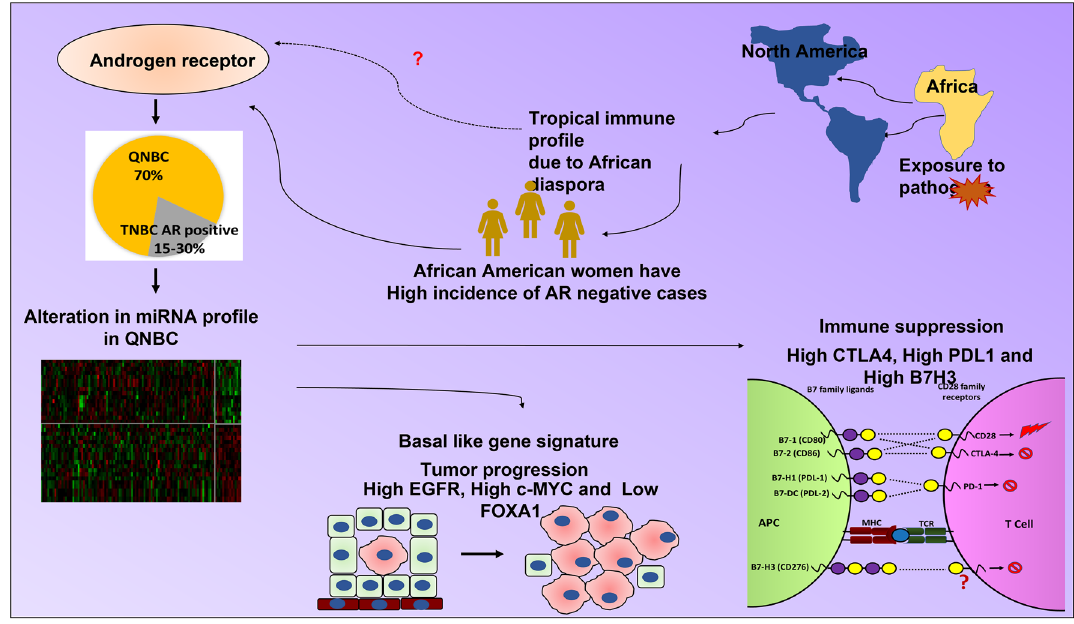
Figure 7. Summary figure/graphical abstract indicating that altered miRNA and gene signatures in QNBCs and cancers of AA patients could be the basis for the immune suppression and tumor progression of